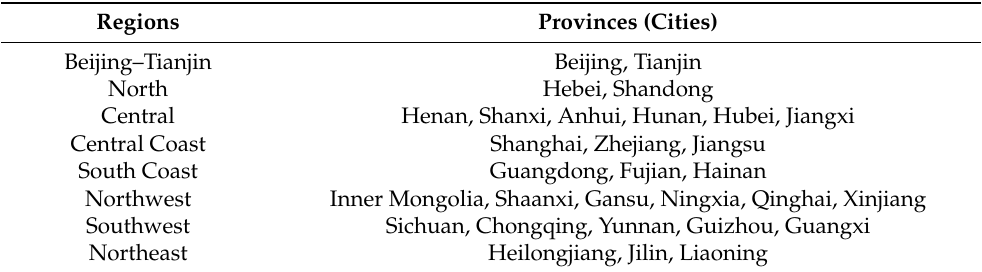
Table 1. The provinces (cities) in eight regions of